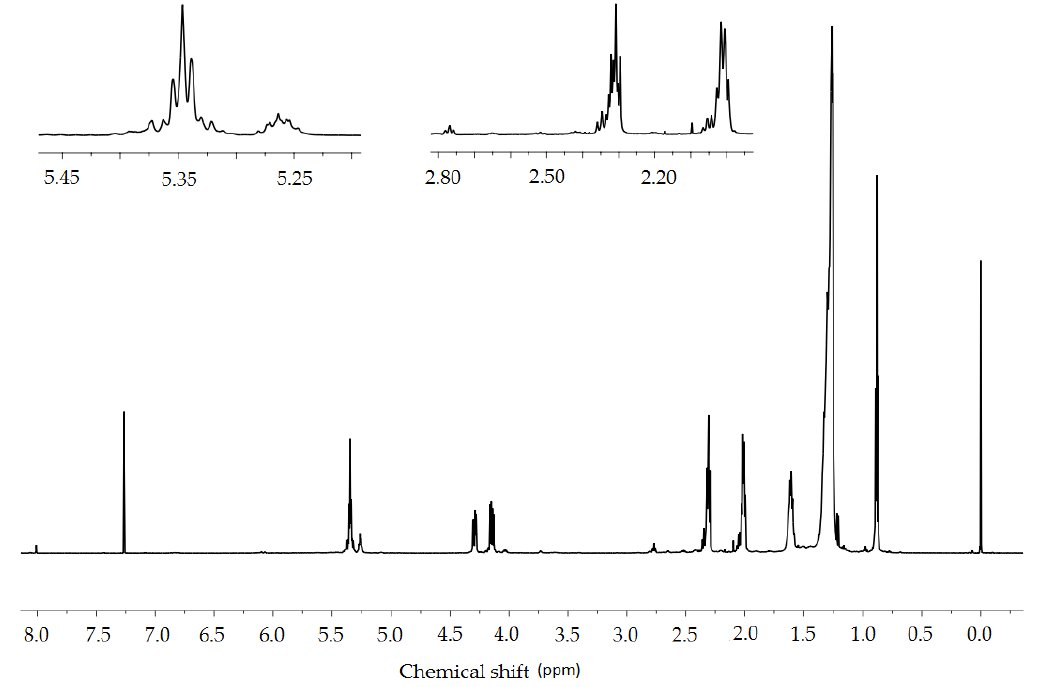
Figure 14. 1 H-NMR spectrum of modified Crambe abyssinica oil in the presence of oxygen and CO 2 .